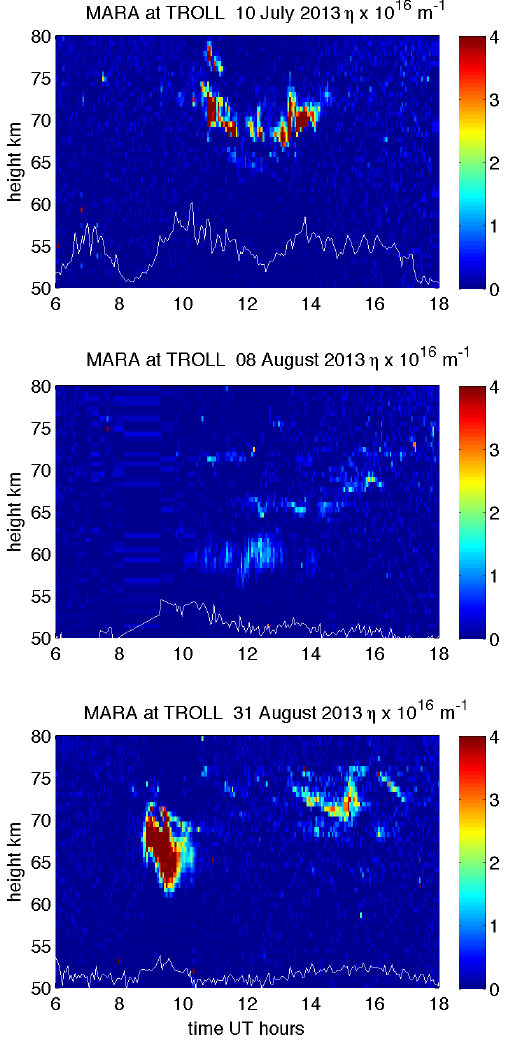
Figure 1. Examples of PWME observed by MARA at Troll, Antarc- tica, during austral winter 2013. Colour scale shows volume reflec- tivity in units of 10 − 16 m − 1 . The white line at the bottom of each panel shows cosmic-noise absorbtion (CNA) at 54.5MHz, where 5km on the height scale corresponds to 1dB